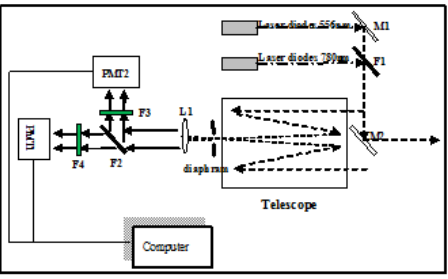
Figure 1 block diagram of the multi-spectral LiDAR system